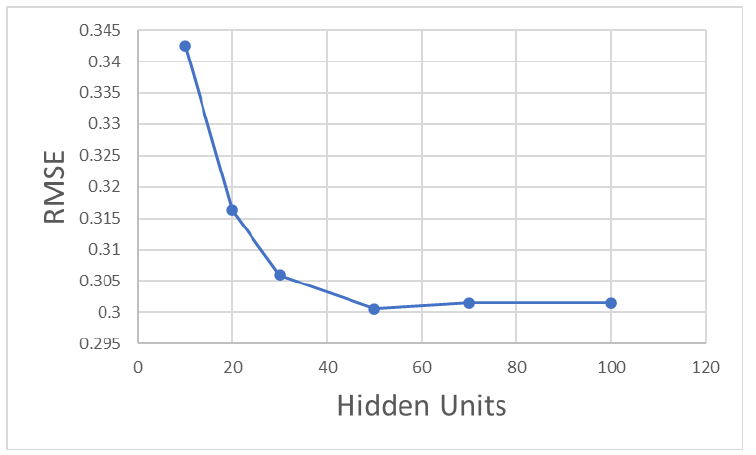
Figure 19. Effect of different hidden units on model accuracy using frequency-domain data.